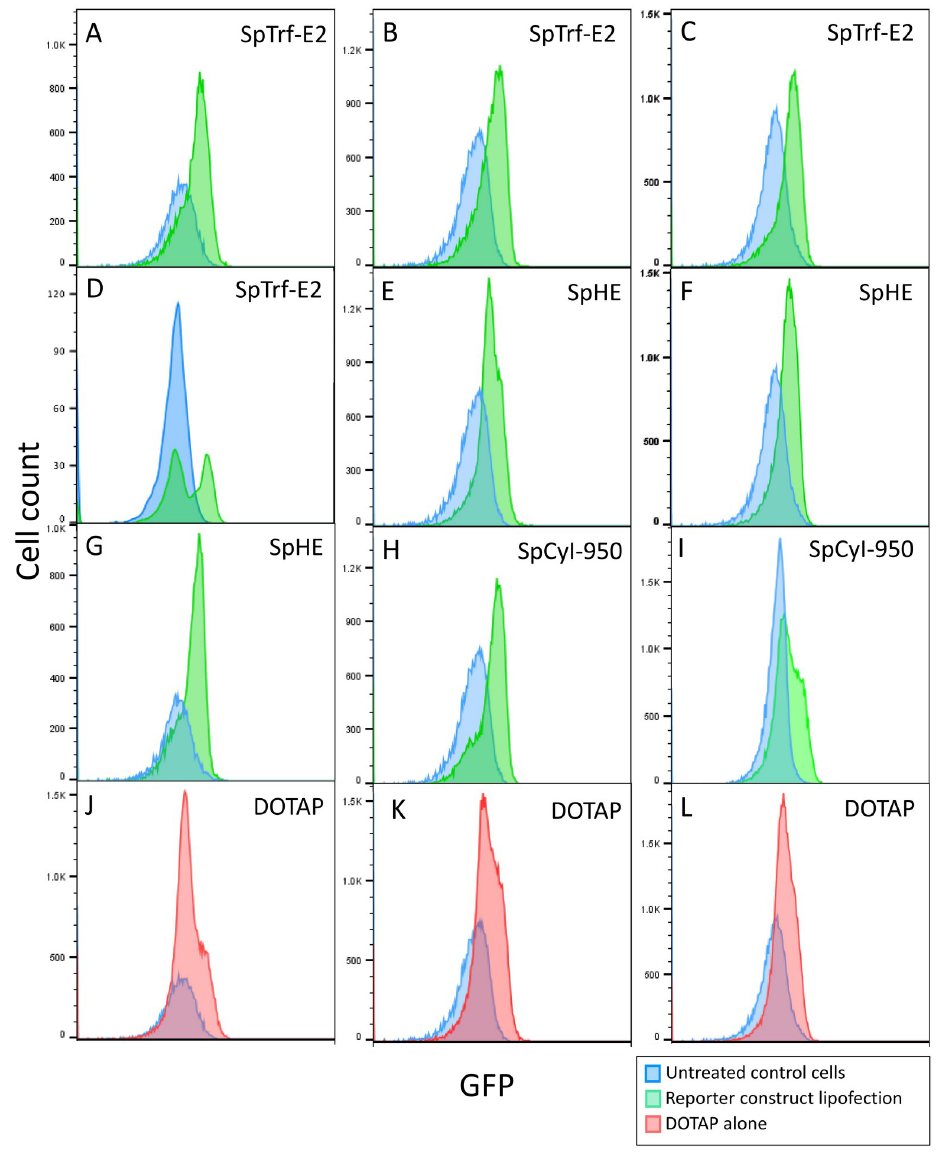
Fig 2. Green fluorescence in coelomocytes is increased in samples lipofected with expression constructs to drive GFP expression. Flow cytometry histograms for green fluorescence are shown for replicate samples of coelomocytes incubated with DOTAP lipoplexes with one of the GFP expression constructs (A-I; green), or with DOTAP liposomes without DNA (J-L; red), or were not treated (blue). Histograms of lipofected coelomocytes are overlaid on histograms of untreated control